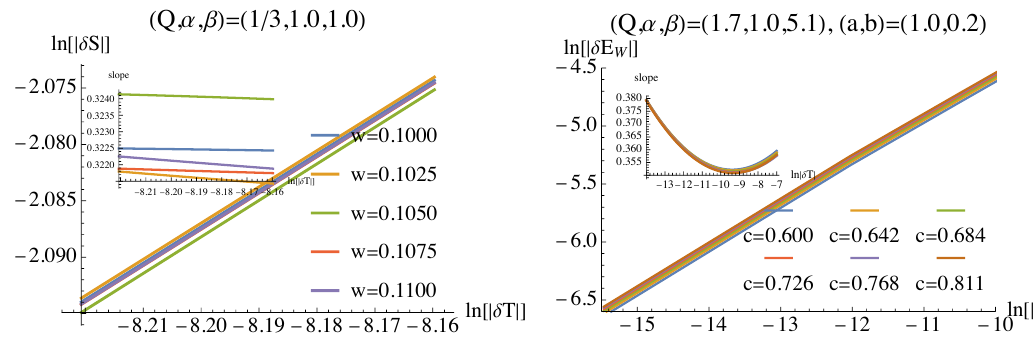
Figure 15 . The scaling behavior between HEE and T , and EWCS and T . The inset in each plot is the slope d ln | δ # | vs. ln | δT | d ln | δT |